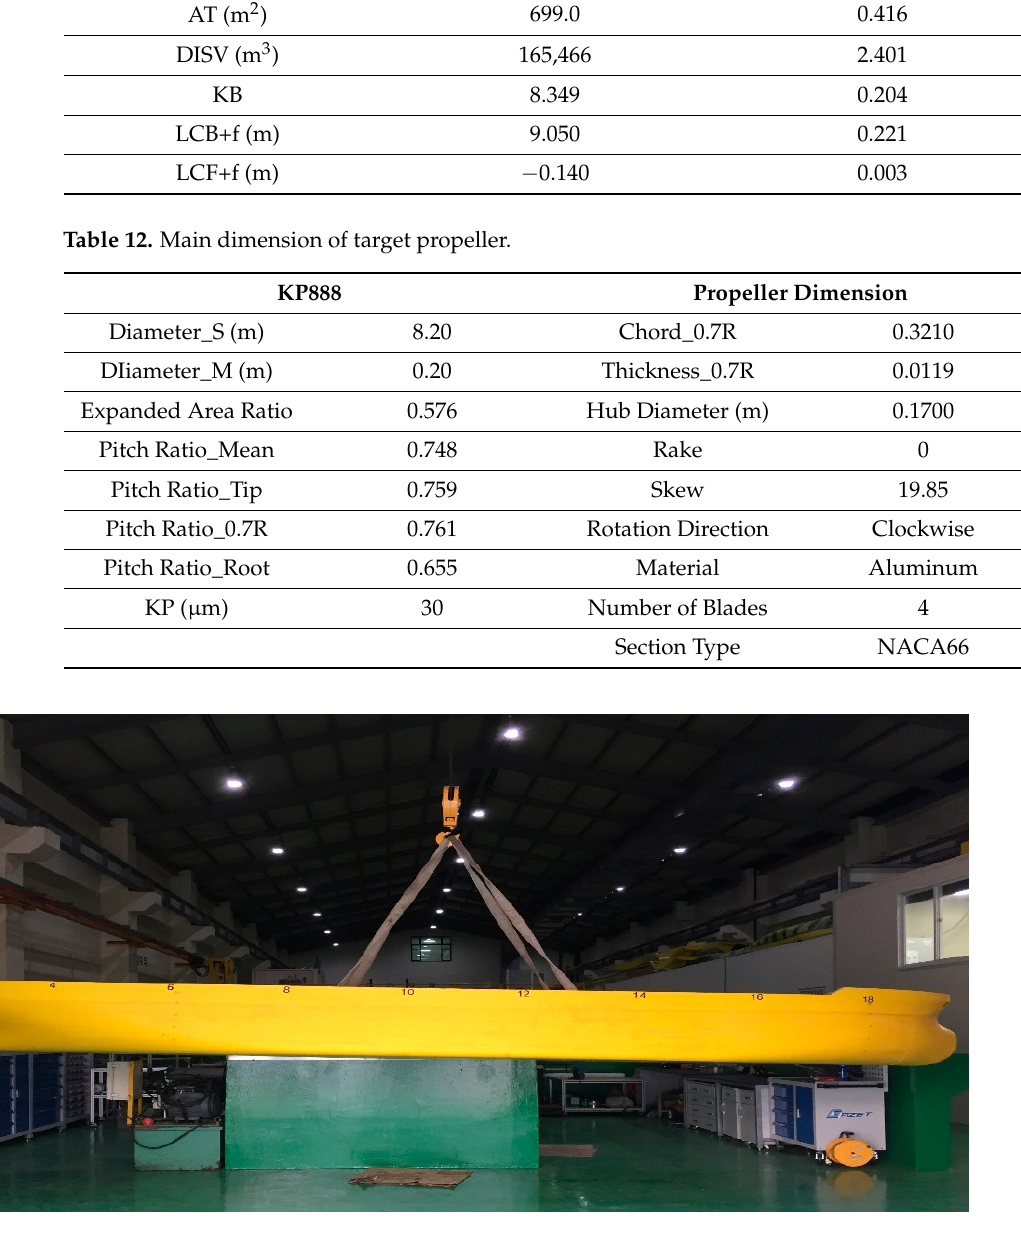
Figure 15. The model ESD of 158K crude oil tanker (Case 7). A comparison of the resistance test results between the bare hull and Case 7 at the design speed of 15.7knots is shown in Table 13. The International Towing Tank Conference (ITTC) 1957 2D method [30] was used to evaluate the performance of the full- scale resistance in order to exclude the uncertainty of form factor. It was found that as the ring acted as an accelerating duct, the Effective HorsePower (EHP) slightly decreased, even though the stator was also attached (Case 7). A comparison of the self-propulsion test results is presented in Table 14. The ITTC 1999 method [31] was used to estimate the full-scale performance, and as a result, an improvement of approximately 2.6% was achieved in terms of DHP. Moreover, when compared with the CFD results, the model test showed somewhat smaller results at the DHP. This difference might be owed to the Reynolds effect in the present compact device. In terms of the chord of the ring, the length is only 8.75 mm, that is, the local Reynolds number is approximately 1 × 10 (cid:2872) . Although the wake region seems turbulent, there might be some laminar region that causes some